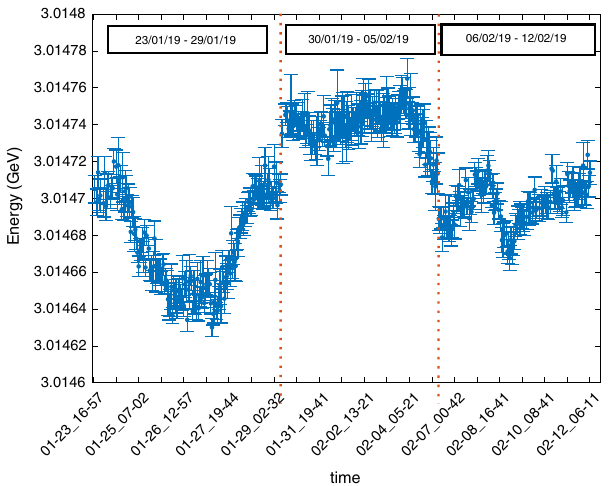
FIG. 10. Energy measurements every hour for a duration of three weeks of user operation. The energy changes over the time on the order of 10